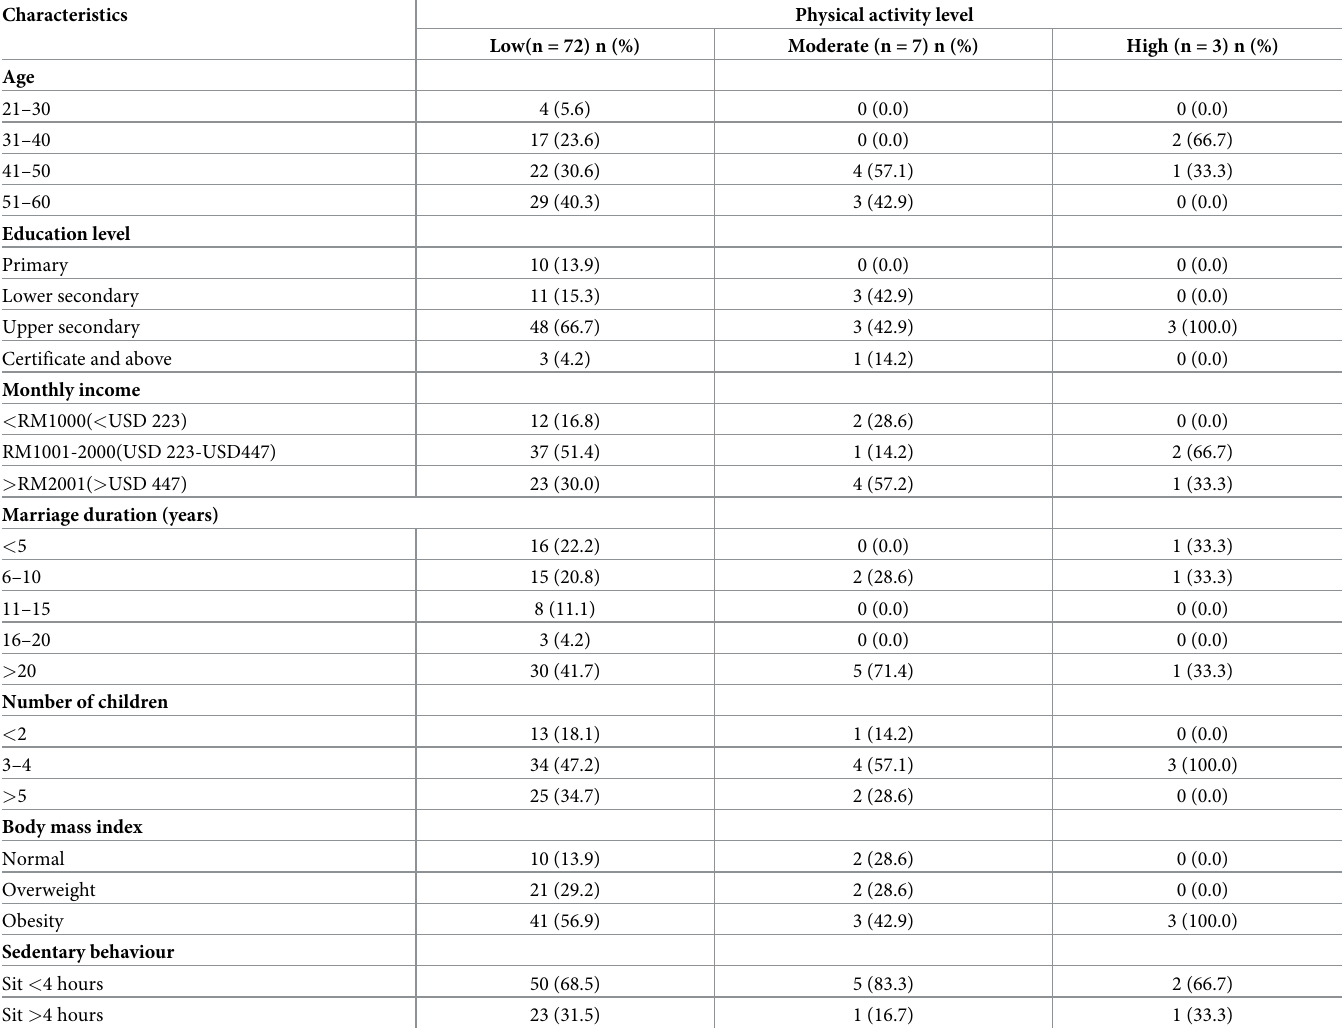
Table 3. Distribution of physical activity level with socio-demographic